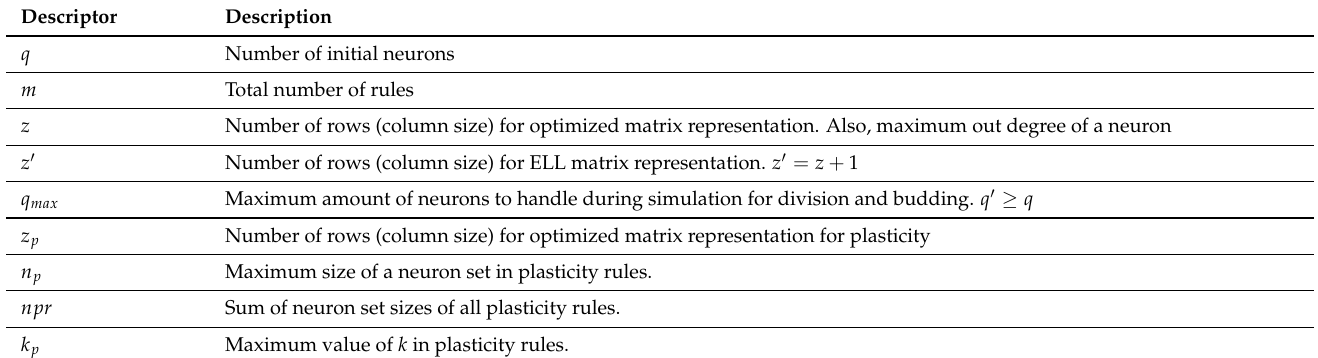
Table 1. Descriptors of an SNP